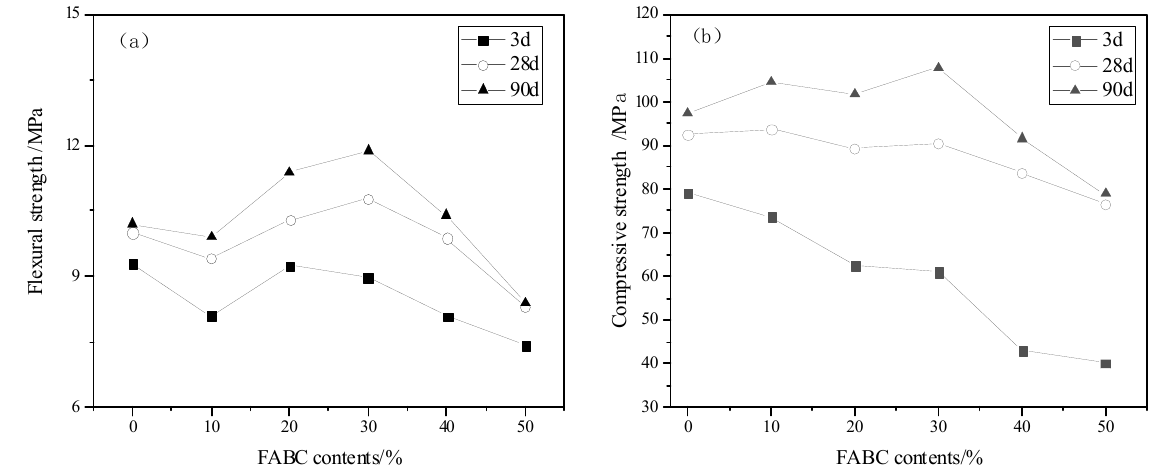
Figure 3. The strength of pastes with different FABC content: ( a ) Flexural strength; ( b ) Compressive strength.